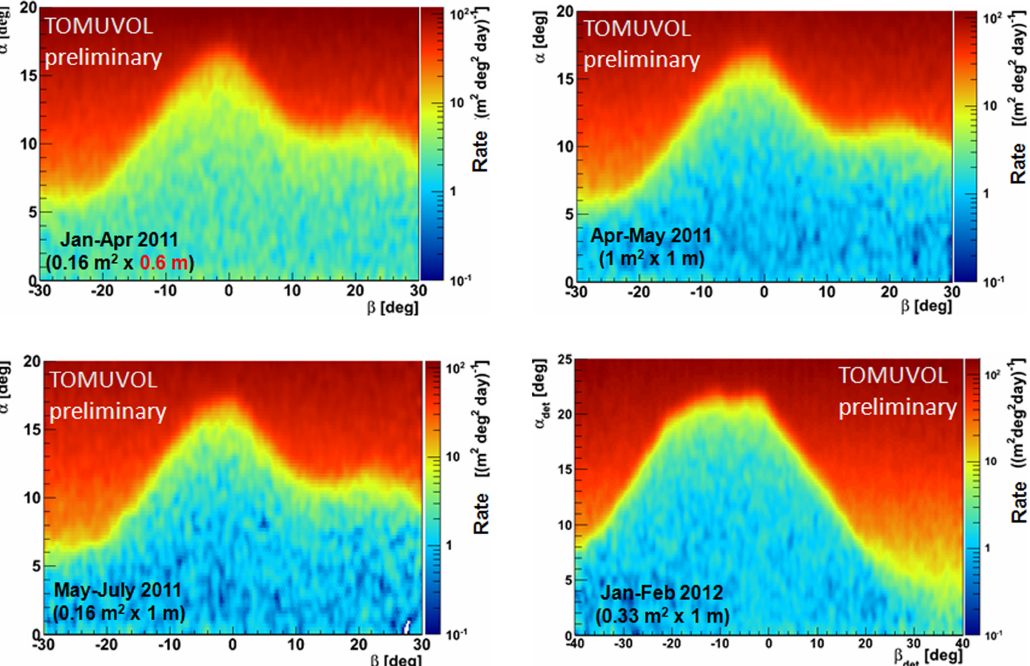
Fig. 2. Shadow cast in the atmospheric muon flux by the Puy de Dˆome, as measured with the various setup configurations discussed herein. Note that the detector acceptance has been factored